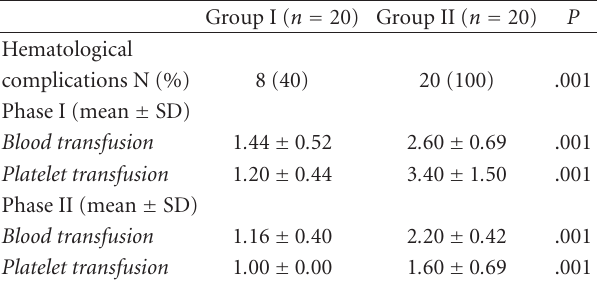
Table 4: Hematological complications (bone marrow hypoplasia and febrile neutropenia) as well as frequency of blood and platelet transfusions (during phases of chemotherapy) in both leukemia